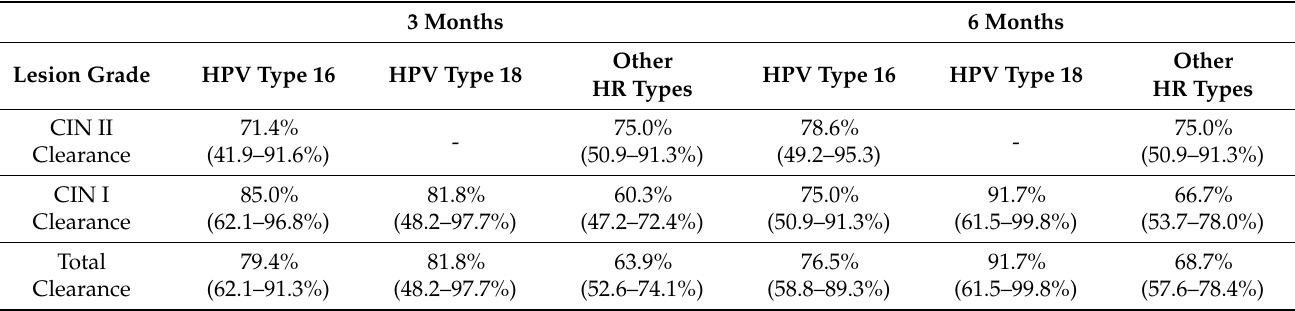
Table 4. Human papillomavirus (HPV) clearance rates 3 and 6 months after a single topical treatment of with 85% trichloroacetic acid.